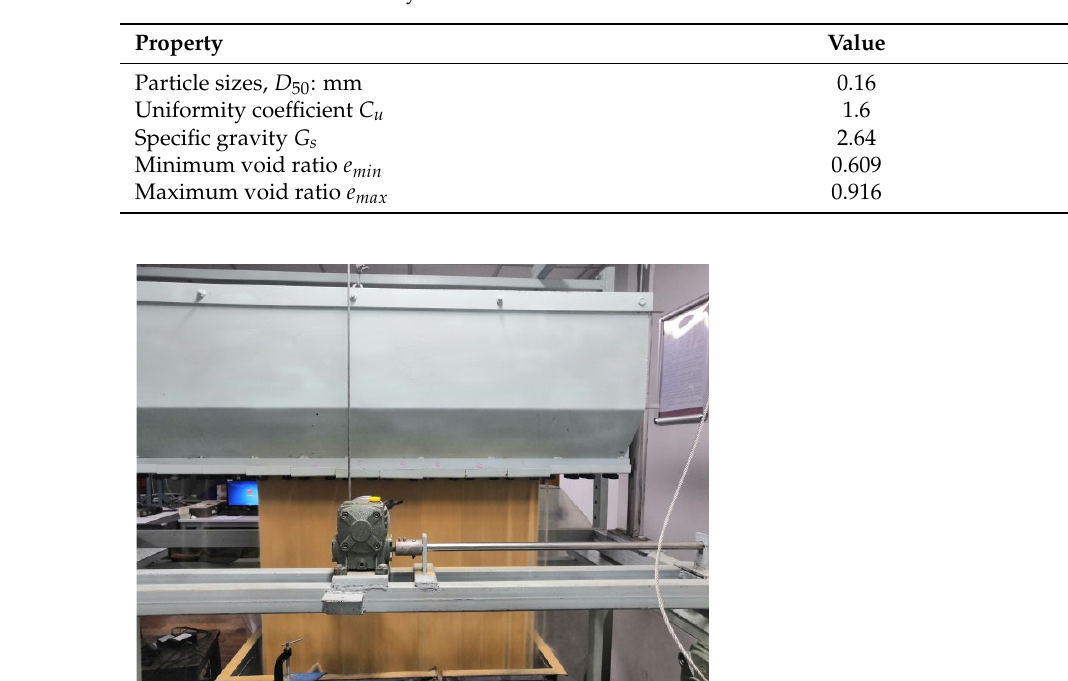
Figure 3. Grading distribution curve of Toyoura sand. Table 1. Characteristics of Toyoura sand.